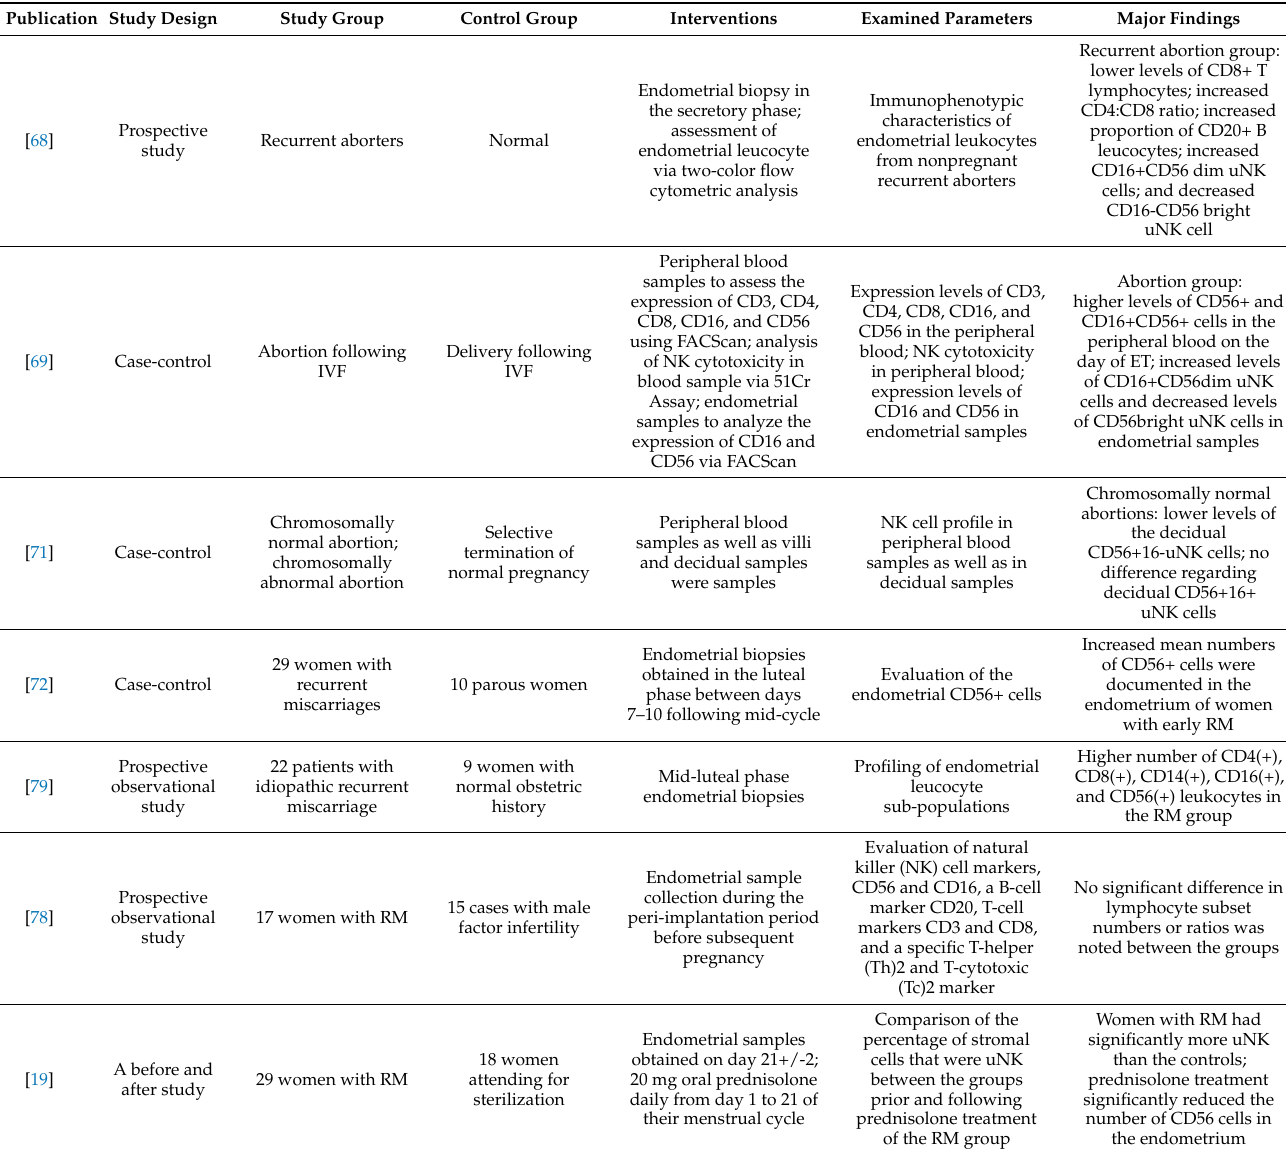
Table 2. Summary of the current evidence with regard to the role of uterine natural killer cells in recurrent miscarriages, highlighting the examined parameters as well as the major findings of the